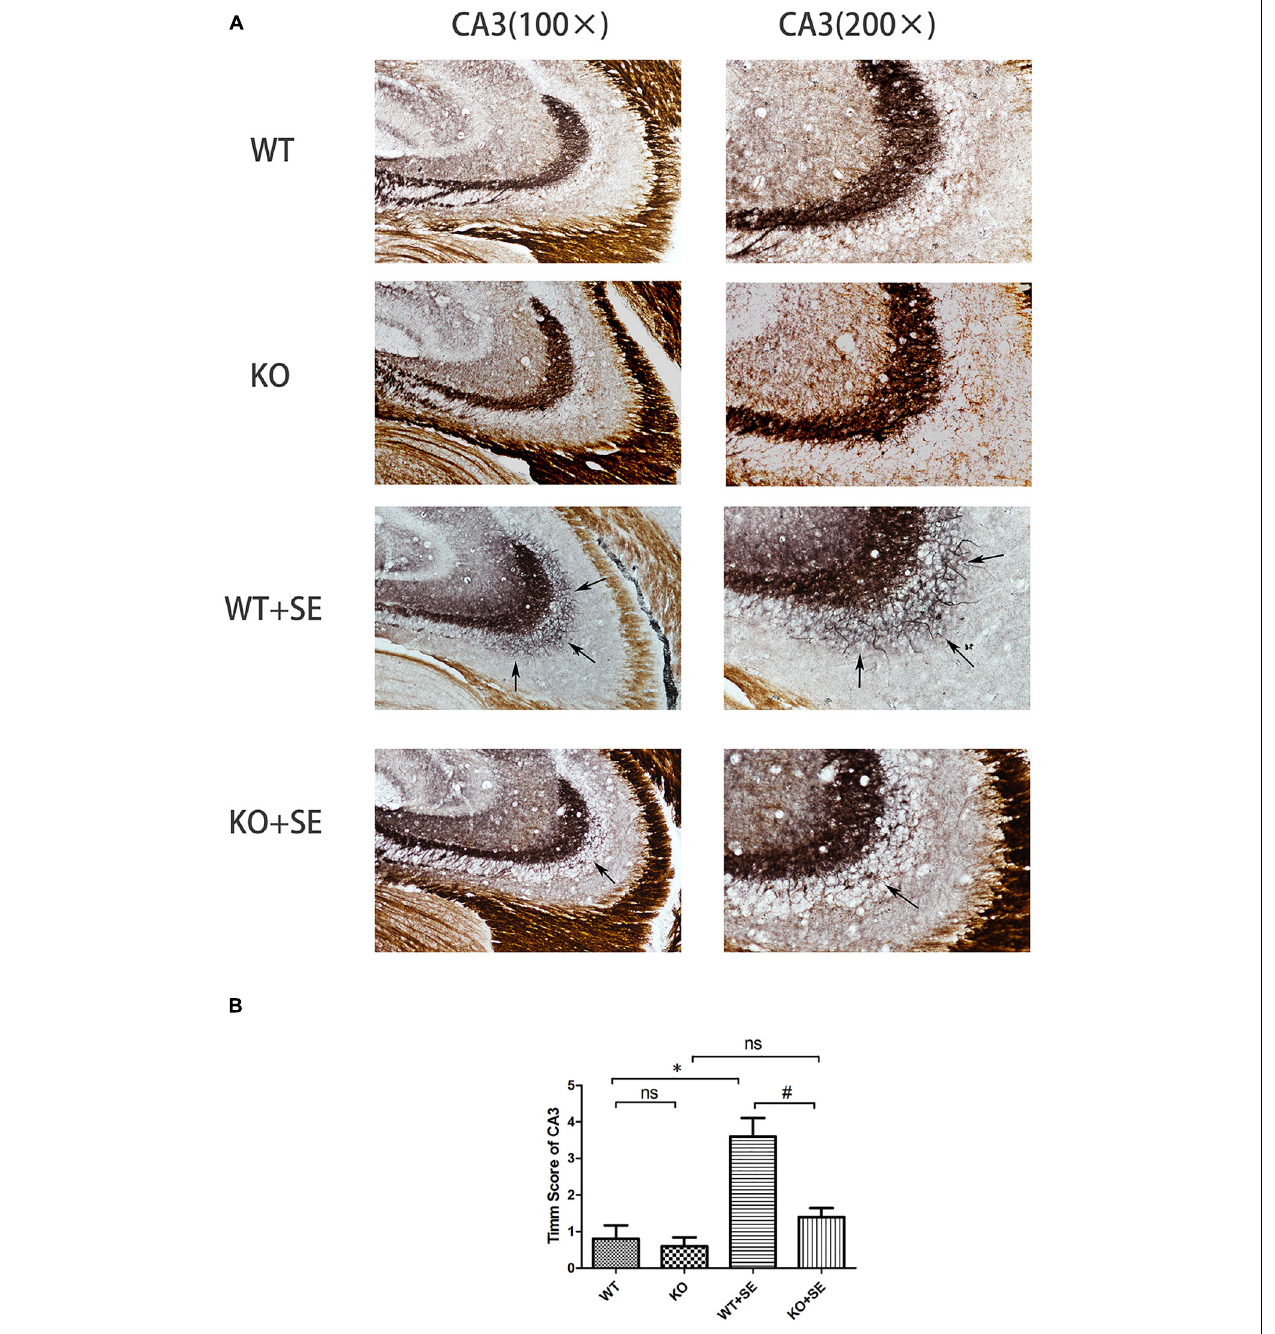
FIGURE 3 | Juvenile seizures increased mossy fiber sprouting (indicated by the arrows) in the pyramidal cell layer of the hippocampal CA3 area of WT mice, but this effect was attenuated in KO mice. (A) Timm staining in CA3 subfield; (B) Timm score analysis. ∗ P < 0.05, compared to WT group, # P < 0.05 compared to WT + SE group, ns means no statistical